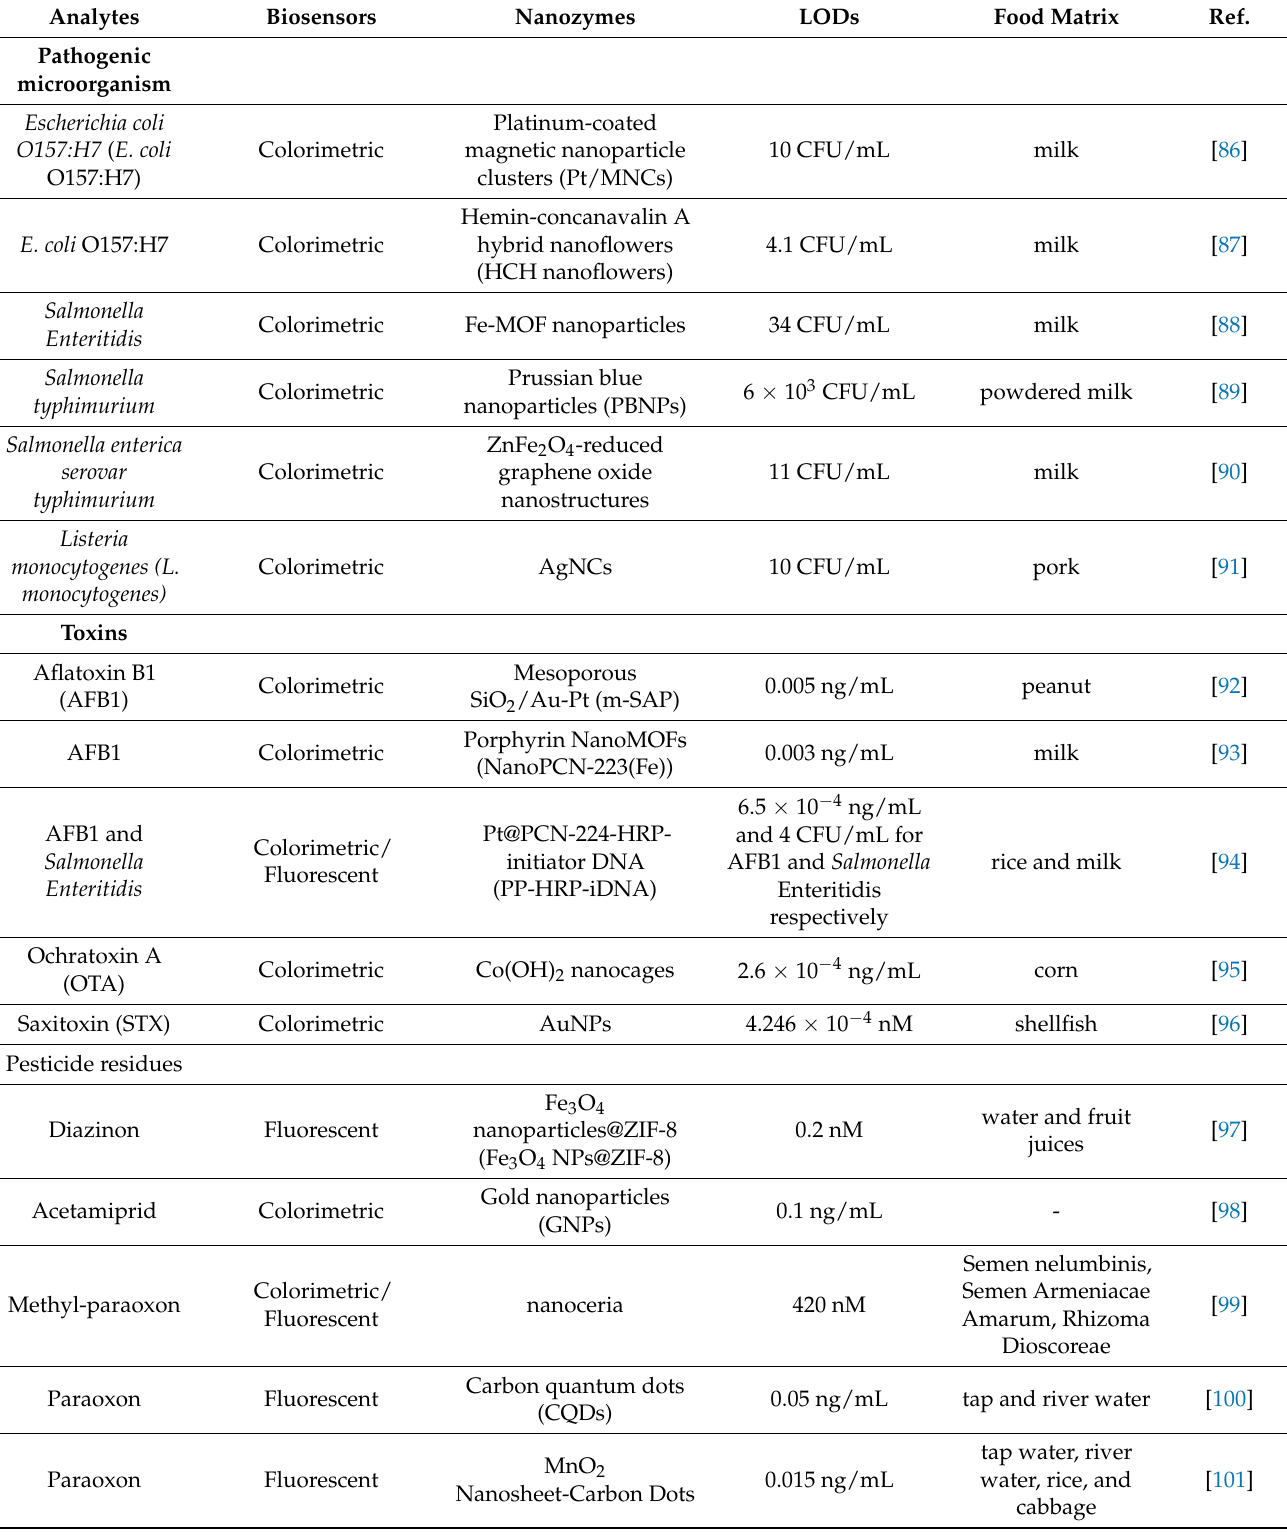
Table 1. Nanozyme-based biosensors for the detection of food